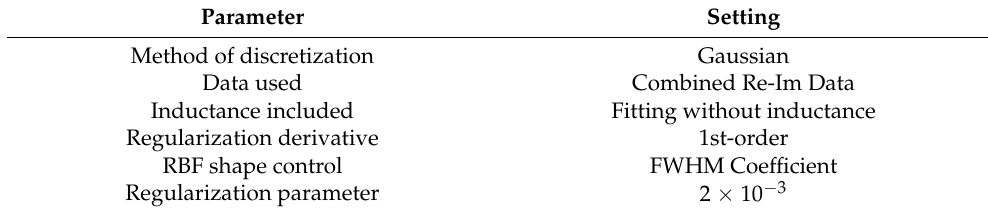
Table 4. Detailed setup of DRT calculation.